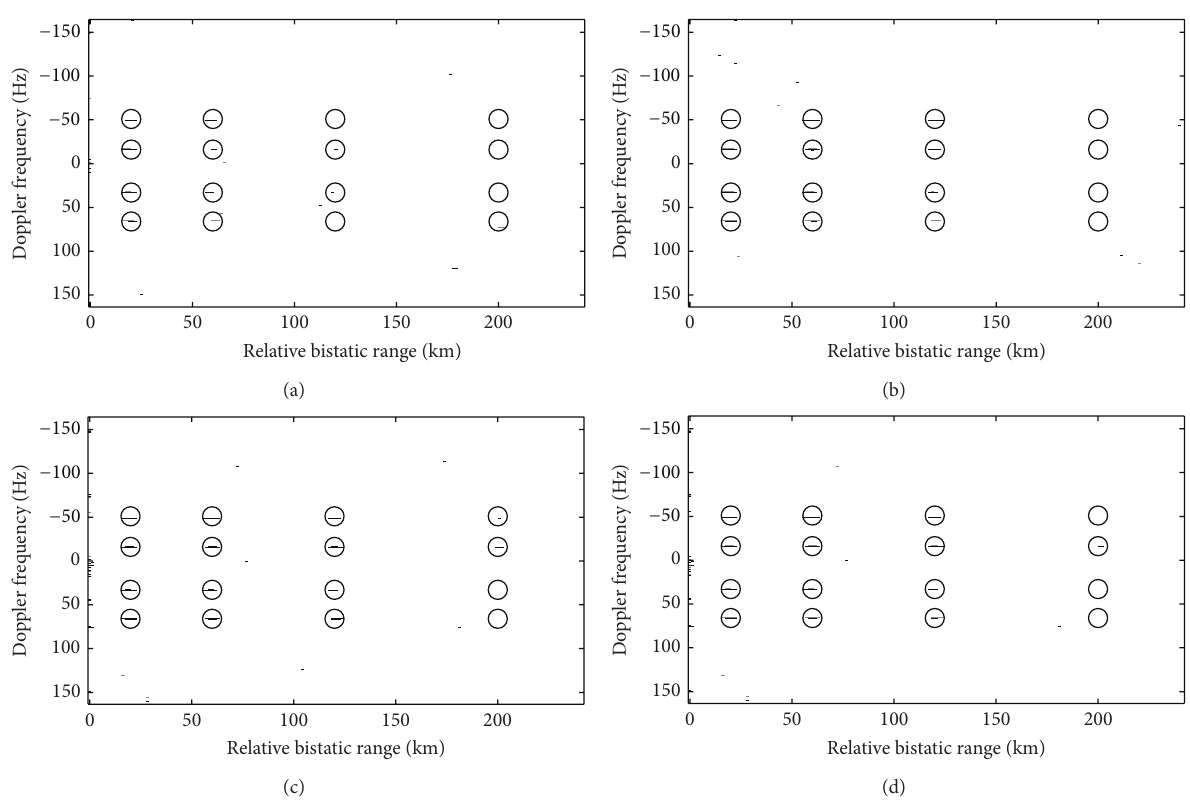
Figure 10: Detection results in the presence of a single stationary obstacle (DoA away from targets’ DoAs) for (a) side lobe control by central element tapering (nonadaptive), (b) optimum filter (c) principal eigenvalue approach, and (d)